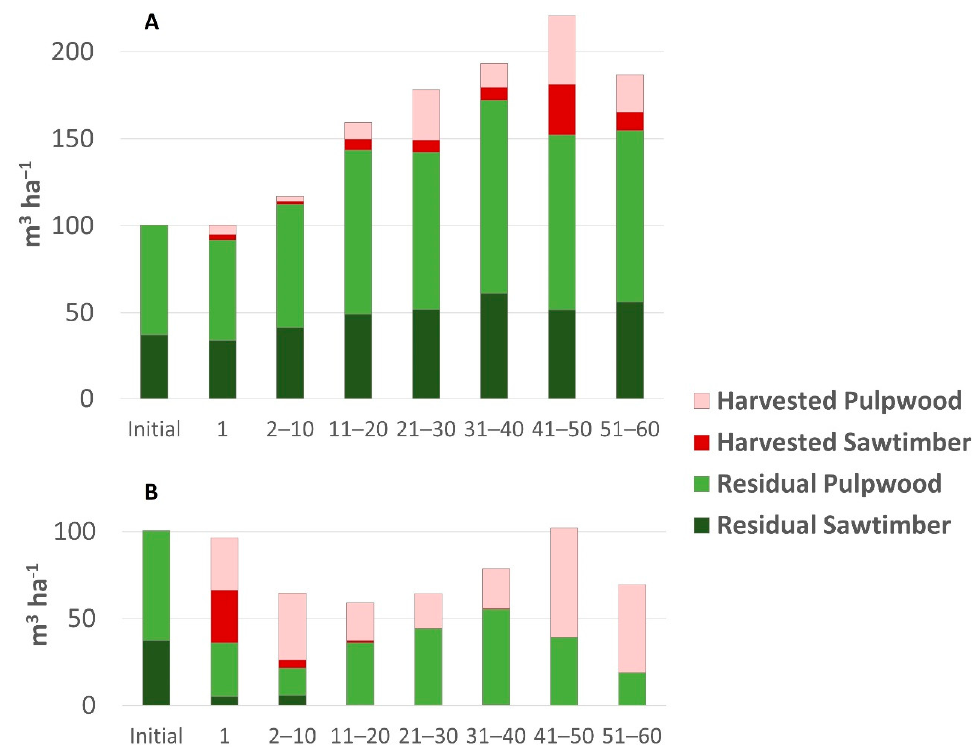
Figure 5. Modeling results from two management regimes in the Mountains of the Dawn region: ( A ) decadal yield and residual stocking from EF management, and ( B ) management to maximize net present value; residual stocking is merchantable volume remaining in the forest at the end of each time period shown. See Supplementary Materials A for more details.